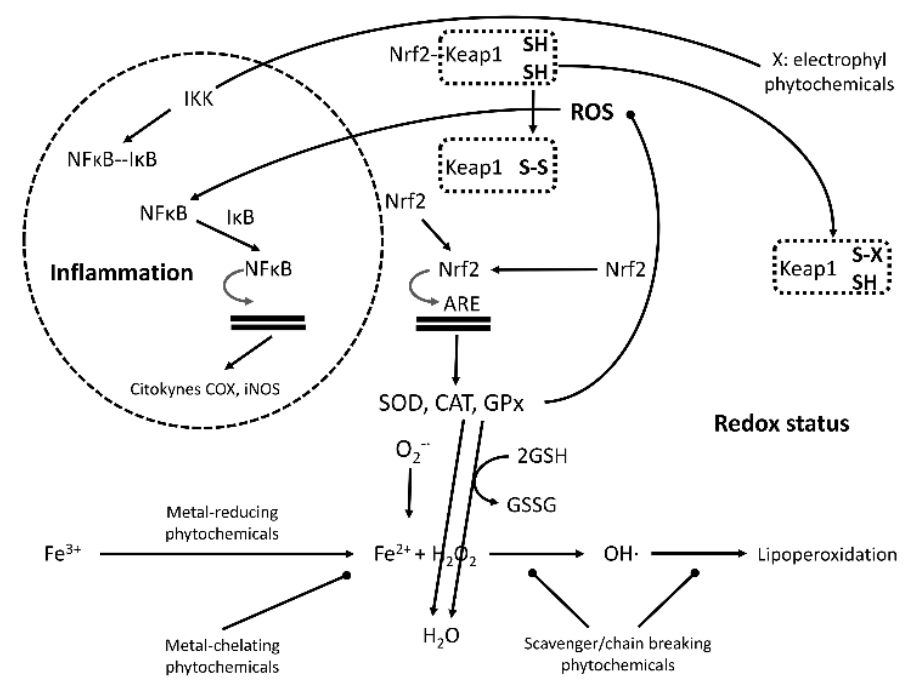
Figure 3. Glutathione (GSH); glutathione S -transferases (GSTs); glutathione peroxidase (GPX), superoxide dismutase (SOD); catalase (CAT); nuclear factor-erythroid 2-related factor 2 (Nfr2); antioxidant responsive elements (ARE); kelch-like ECH-associated protein-1 (Keap1); nuclear factor- kappa B (NF-κB); Iκ kinases (IKK); CREB-binding protein (CBP).